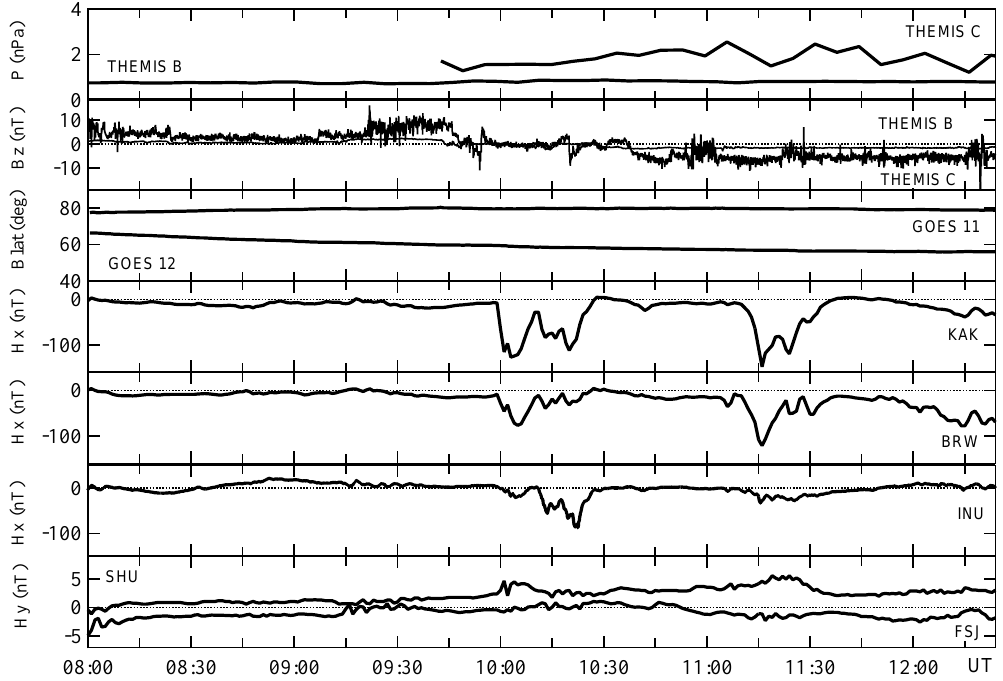
Fig. 2. From top to bottom: THEMIS-B/C solar wind/magnetosheath dynamic pressure, THEMIS-B/C Bz magnetic field component, GOES-11/12 magnetic field latitudes, and high latitude ground magnetometer X